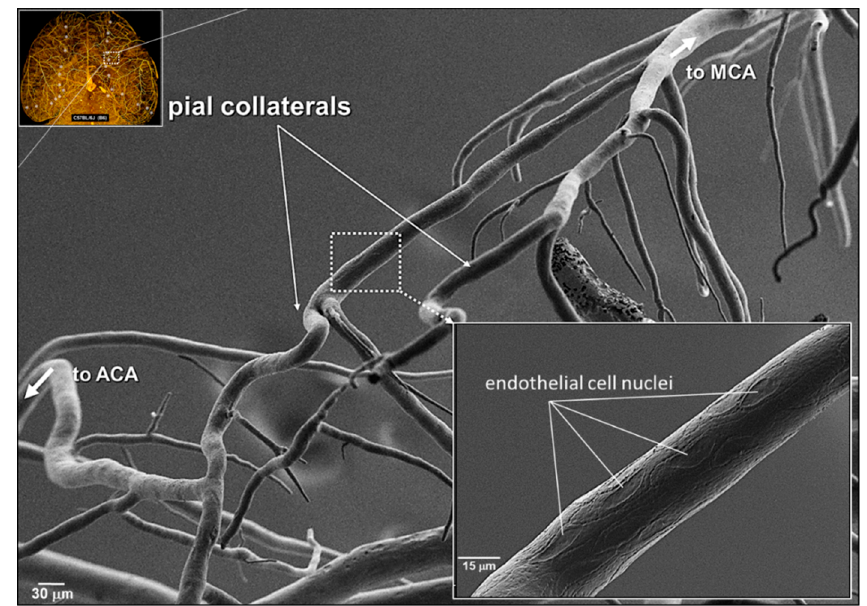
Figure 1. Pial collateral endothelial cells are aligned with the vessel axis. Scanning electron micrograph (SEM) of a corrosion cast of Batson’s #17-filled cerebral pial arterial vessels and 2 collaterals, fixed after maximal dilation, which overlie the watershed zone between the anterior (ACA) and middle (MCA) cerebral artery trees. Upper inset, Microfil ® cast of arterial vessels and collaterals (stars) in optically cleared brain. SEMs were obtained from six mice (see also Figure S1). Penetrating arterioles are evident branching from collaterals and pial arterioles.